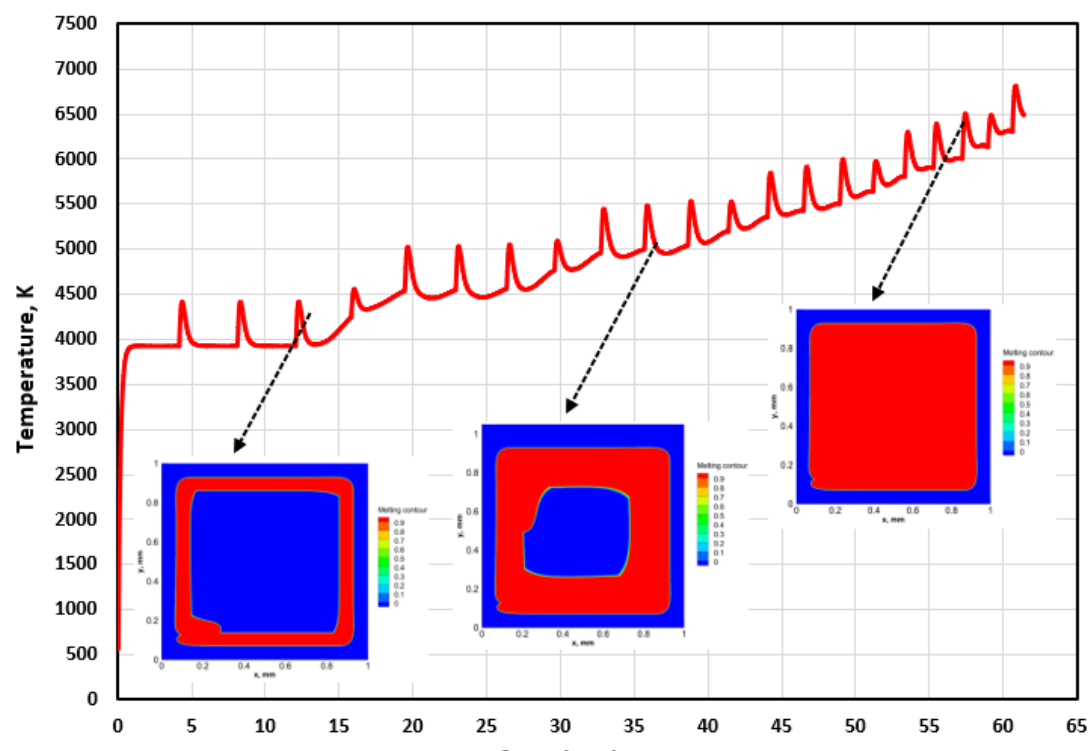
Figure 16. Temperature history of the small concentric in-out strategy